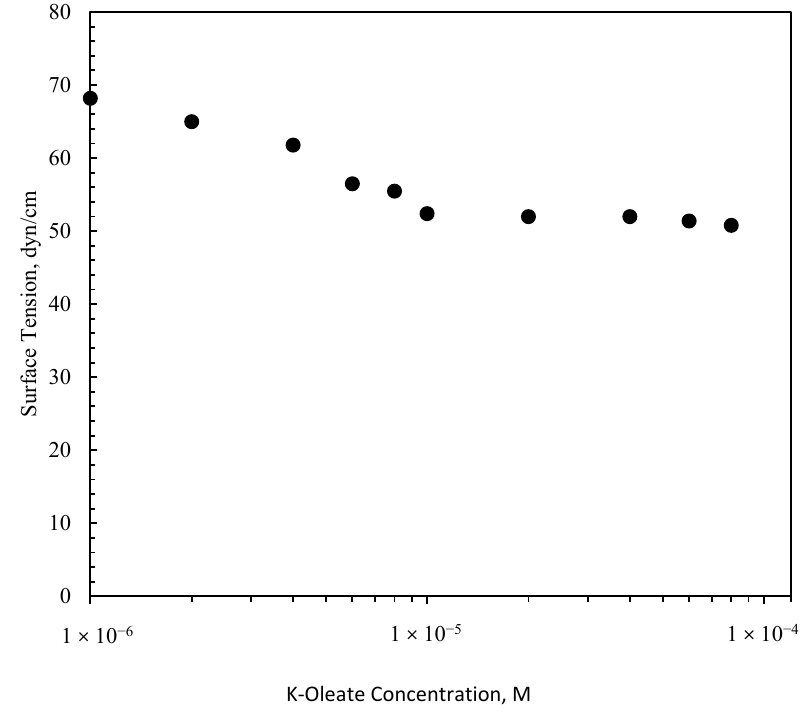
Figure 6. Surface tension measurements as a function of K-Oleate concentration.